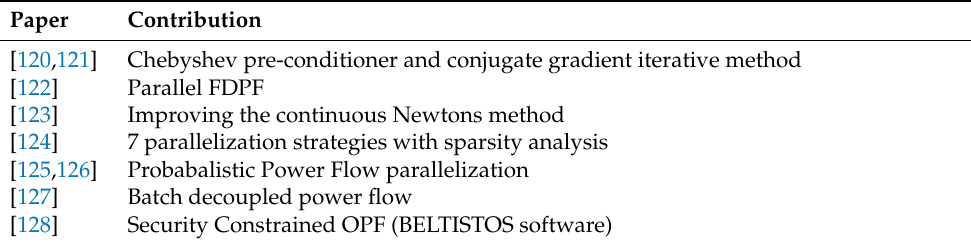
Table 3. Power flow SIMD-based state-of-the-art studies.